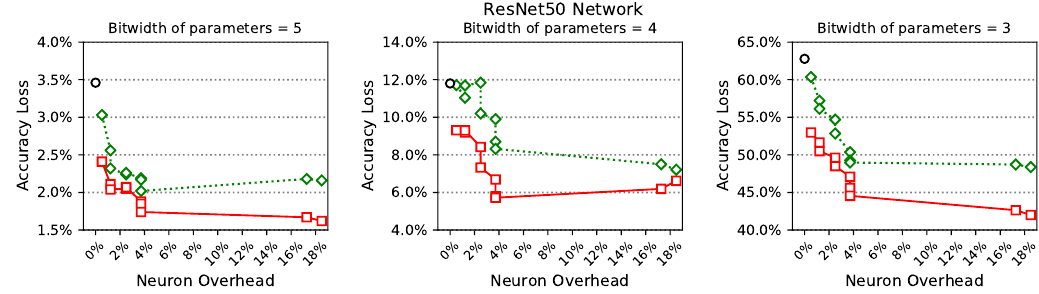
Figure 7. The proposed k -SDA can decease the accuracy loss during mapping using extra